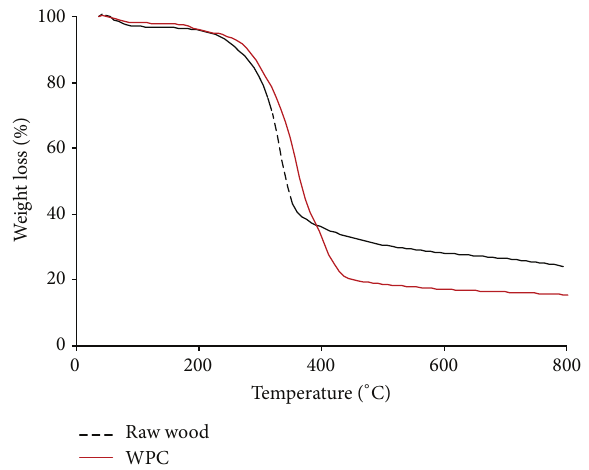
Figure 7: Typical TGA curves of raw Jelutong wood and WPC